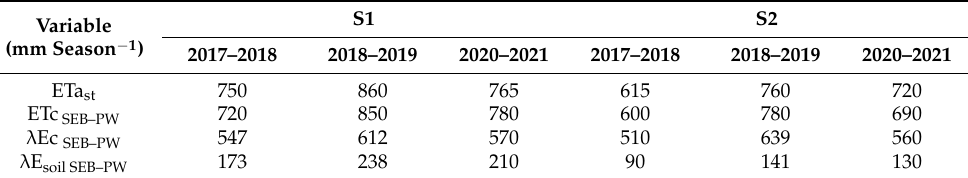
Table 5. Cumulative ET, crop T, and ETa at sites S1 and S2 for the 2017–2018 (A), 2018–2019 (B),